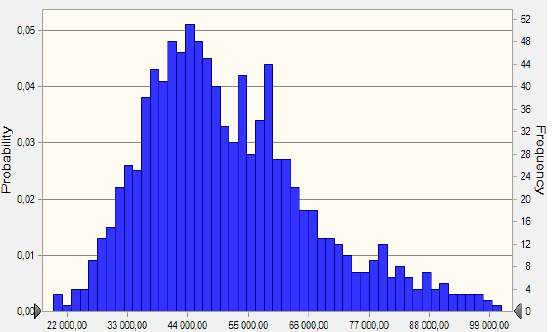
Figure 12. Probability distribution of the present value of incomes from the accommodation rental facilities for 10 years in the region of Poprad–Vysok é